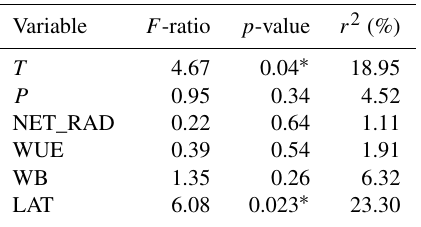
∗ Indicates statistical significance at a significance level of